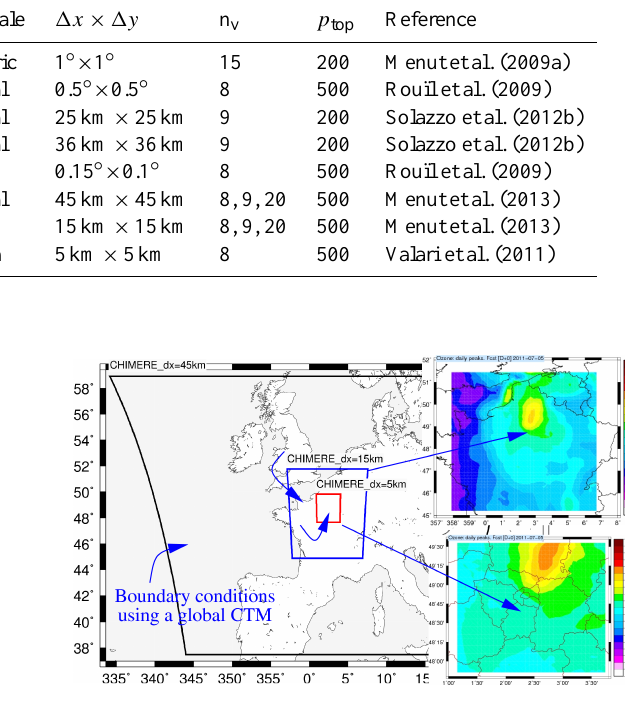
Fig. 6. Example of simulation domains for CHIMERE, and corre- sponding surface ozone concentrations maps. The largest domain (d x = 45km) uses a global model climatology for boundary condi- tions, and forces itself the medium domain, d x = 15km, over the North of France, itself forcing the small domain, d x = 5km, over the Paris area.